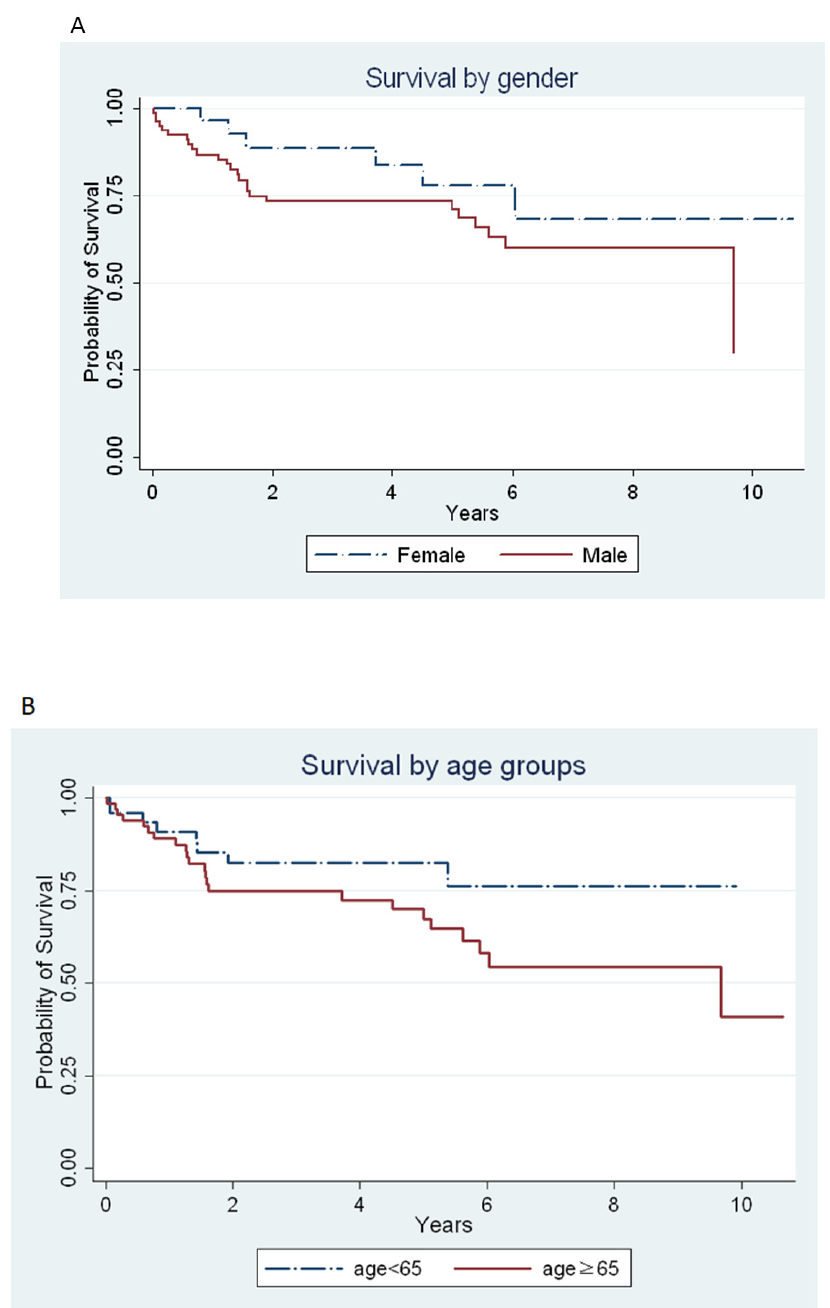
Figure 2. The survival of the entire cohort from initial diagnosis to death, last follow-up, or at the end of the study period. ( A ) A comparison between females and males (mean survival, 8.5 years vs. 6.7 years; p = 0.122). ( B ) A comparison between individuals younger than 65 years and those older than 65 years (mean survival, 8.1 years vs. 6.9 years; p = 0.09).